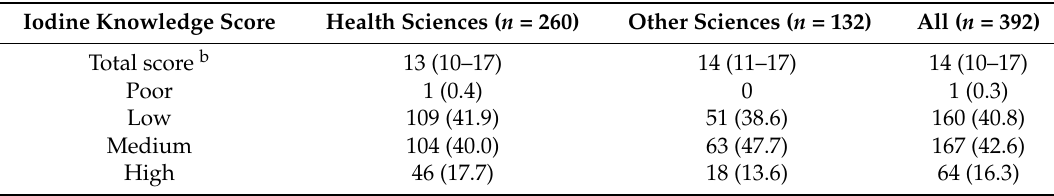
Table 5. Iodine knowledge scores in young Norwegian women attending health-related study programs and other study programs ( n = 392) a.